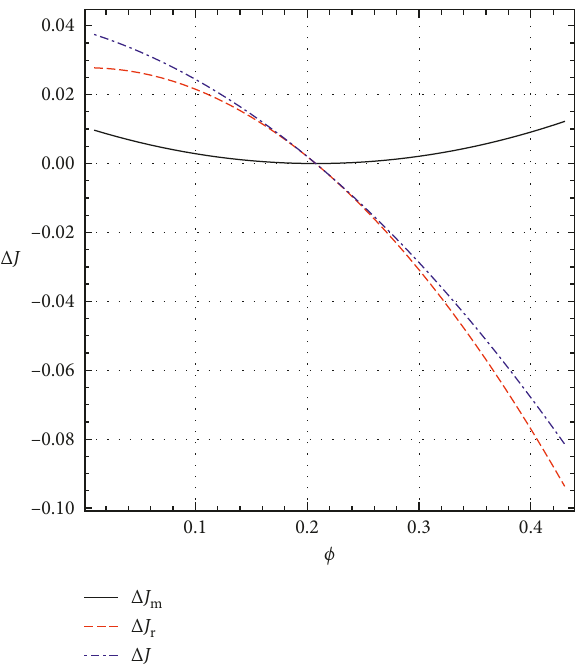
Figure 2: Comparison of steady-state profits with ϕ .